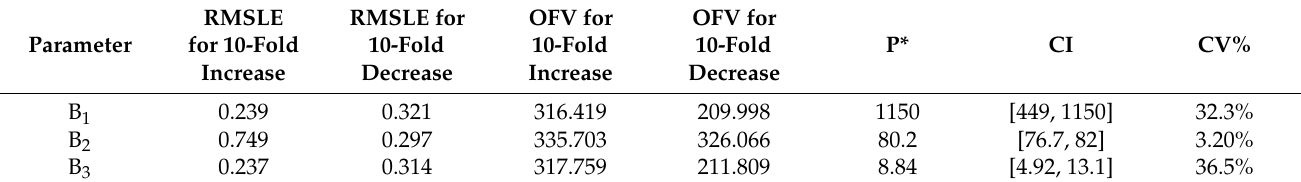
Table 1. Quantitative measures of model sensitivity including RMSLE and OFV values for 10-fold changes are represented for each of the expansion function parameters. Optimized model-specific parameters (P*), as well as their 95% confidence intervals (CI) are included for each RSR parameter. CV% was calculated by dividing standard deviation by the mean and multiplying by 100%. Complete parameter estimates available in Table